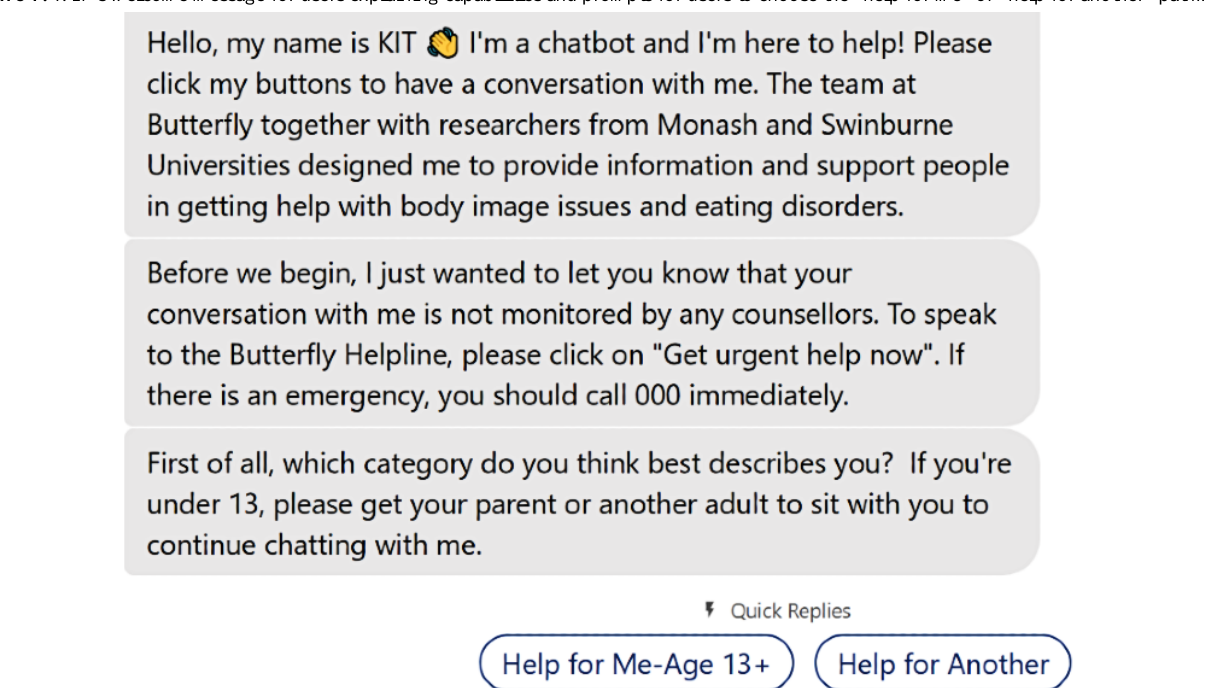
Figure 1. KIT’s welcome message for users explaining capabilities and prompts for users to choose the “help for me” or “help for another” pathway.